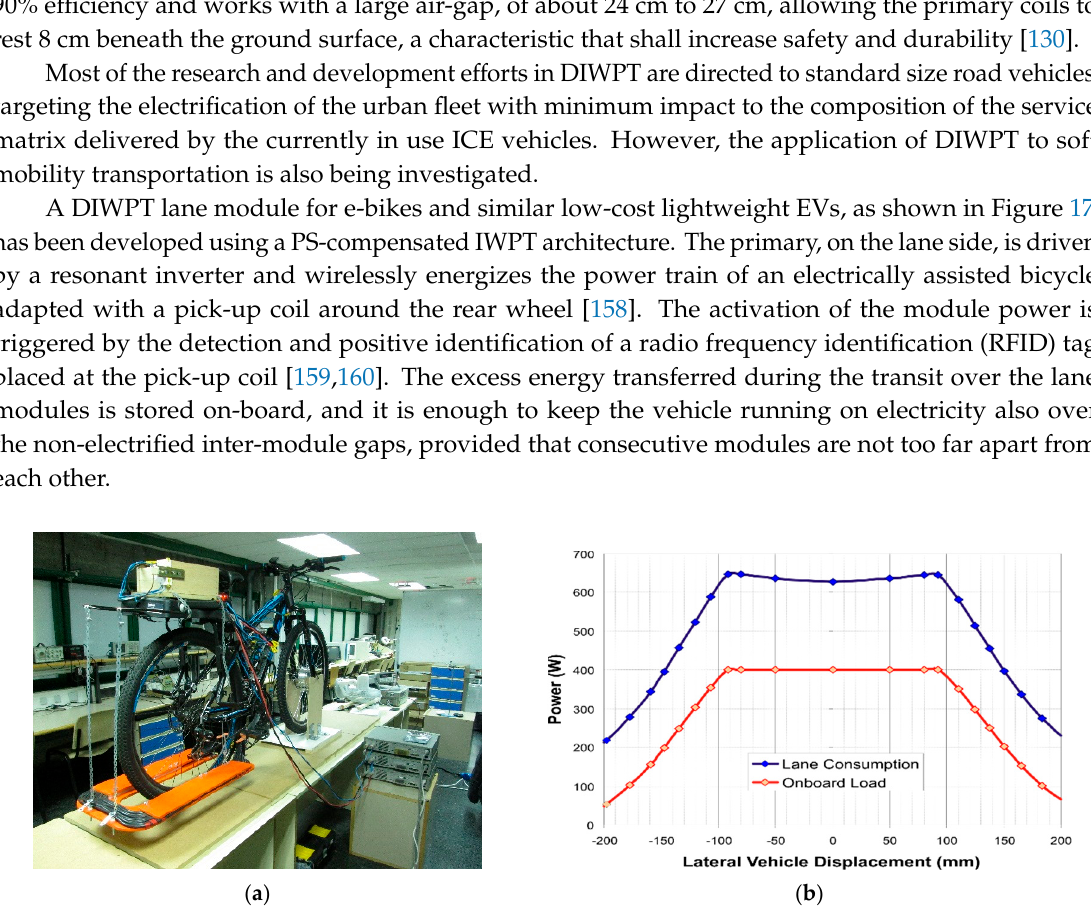
Figure 17. Dynamic inductive wireless power transfer (DIWPT) for e-bike: ( a ) prototype jointly developed by the University of Minho and the University of Vigo, during tests on workbench; ( b ) experimental curves of input power (blue) and net transferred power to powertrain (red) vs. lateral misalignment.